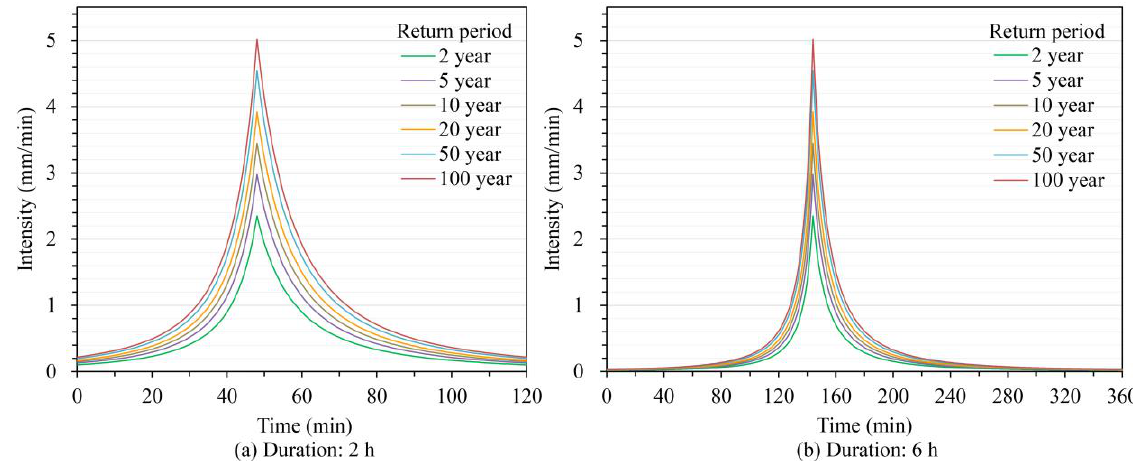
Figure 9. Synthetic hyetographs of 2 h ( a ) and 6 h ( b ) design rainfall events of Nanjing.